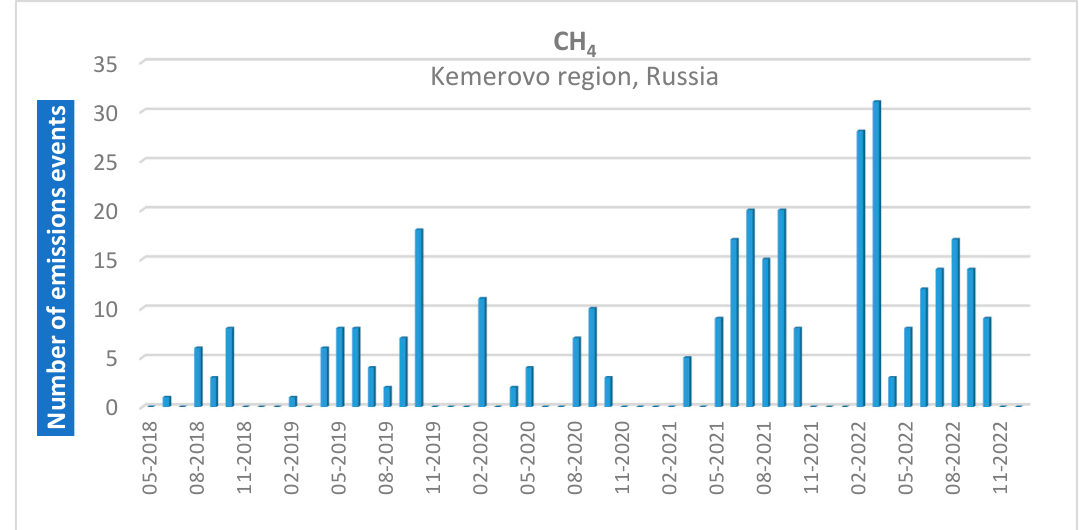
indication of the presence of multiple super-emitters in the Kemerovo region.